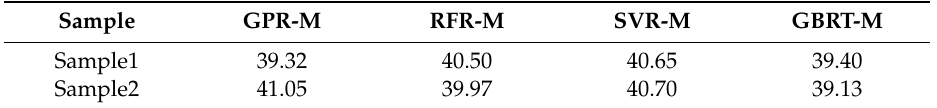
Table 6. The training results of Sample1 and Sample2 based on four generated machine leaning models.